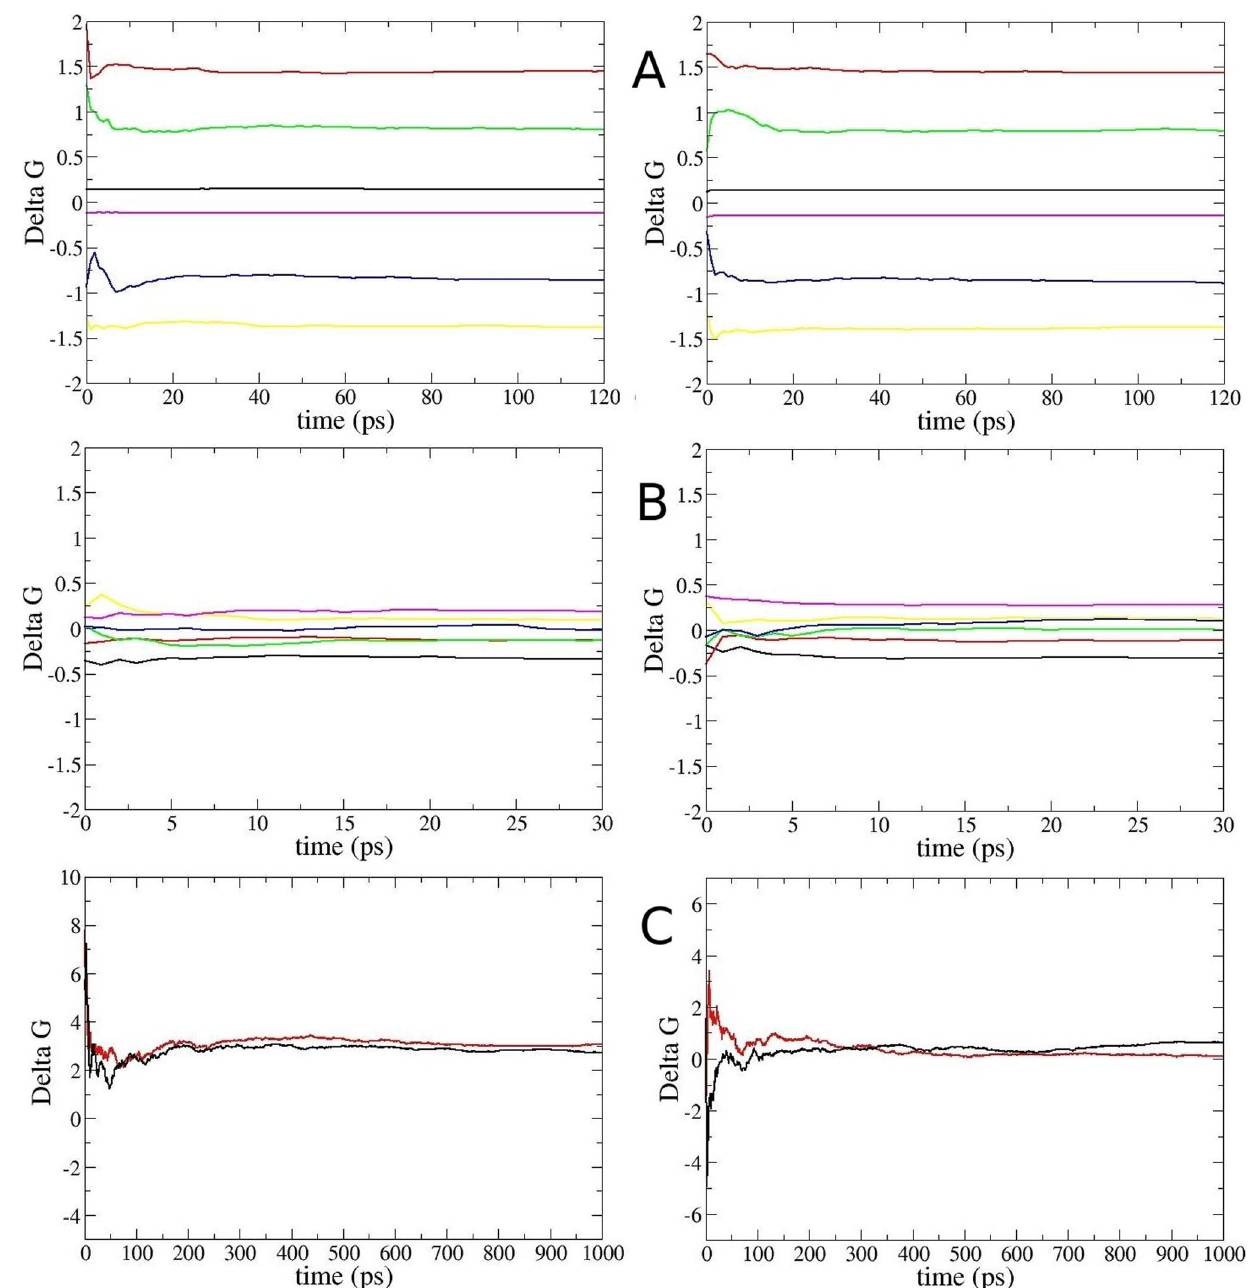
Figure 3. Convergence of the FEP and TI calculations. (A) Convergence of the FEP calculations for discharging/charging of the K18 in ShK in the binding site/bulk. Running averages of D G i for windows at l =0 (black), l =0.2 (red), l =0.4 (green), l =0.6 (blue), l =0.8 (yellow) and l =0.999 (magenta) are plotted as a function of the production time for Kv1.1 (left) and Kv1.3 (right). (B) Similar to A but showing the convergence of the FEP calculations for transformation of the uncharged Lys side chain to that of Ala. (C) Convergence of the TI calculations for discharging/ charging of K18 in ShK in the binding site/bulk. Running averages of the D G values obtained from the TI calculations are plotted as a function of the production time for Kv1.1 (left) and Kv1.3 (right). Both the forward (black) and the negative of the backward (red) results are shown to check for hysteresis effects, which remain well below 1 kcal/mol for both channels.